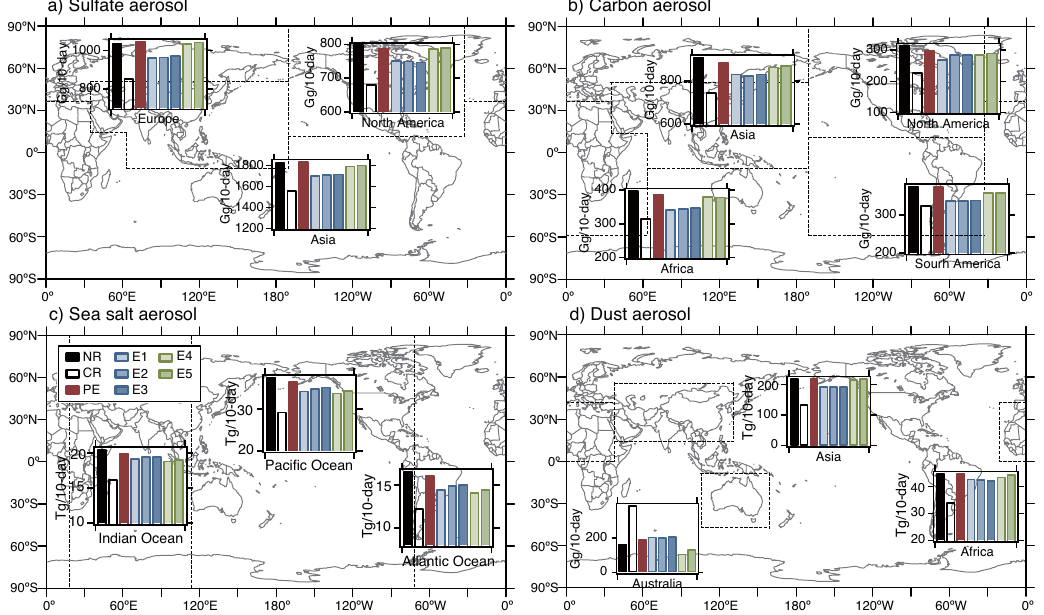
Fig. 9. Comparisons of aerosol emission amounts for (a) SO 2 [Gg/10day], (b) carbonaceous [Gg/10day], (c) sea-salt [Tg/10day], and (d) dust aerosols [Tg/10day]. Boxes within dashed lines show the regions used to calculate the emission